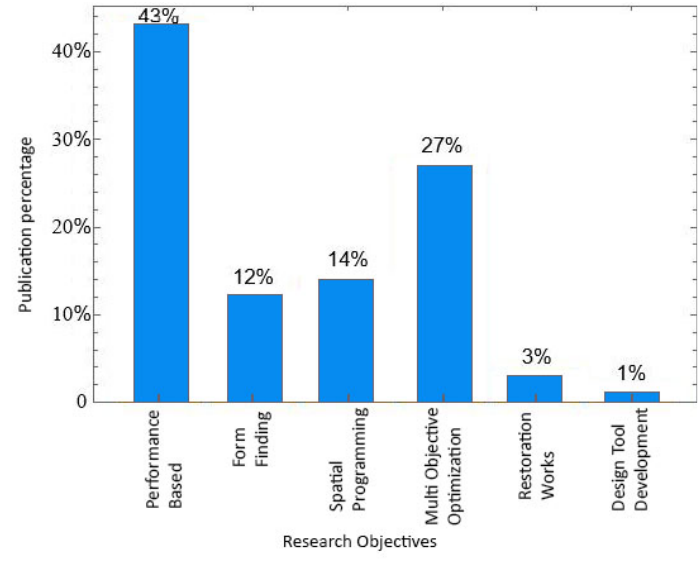
Figure 5 The quantity of articles categorized based on their research objectives Table 3 The significant studies that based on their research